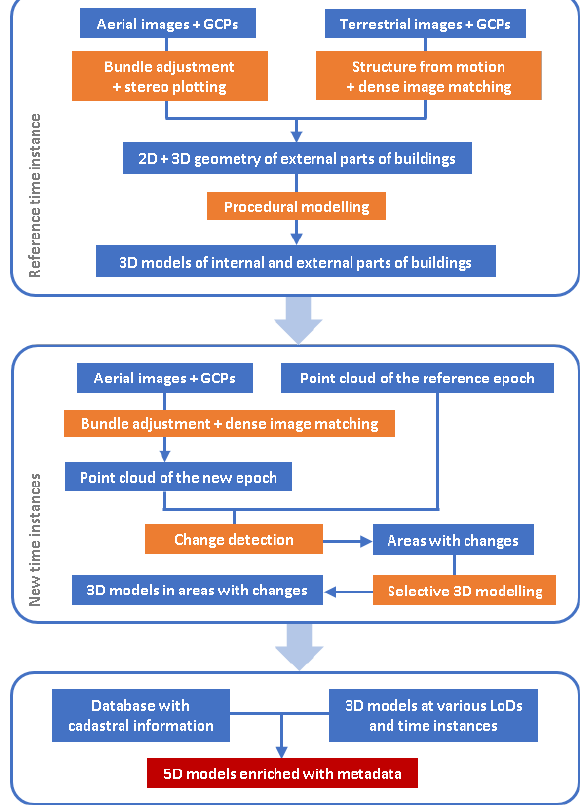
Figure 1. The proposed 5D modelling